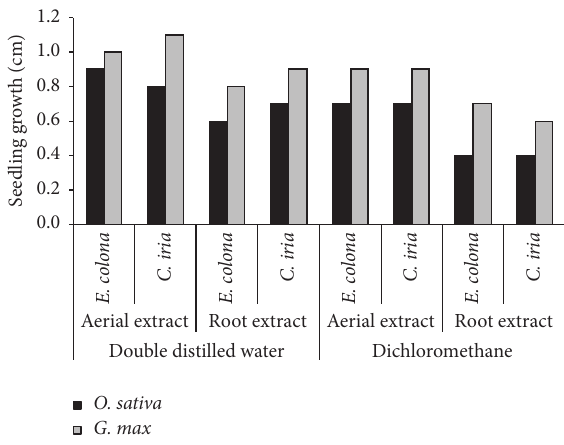
Figure 3: Effect of extracts (100mg/ml) of E. colona and C. iria on seed germination.